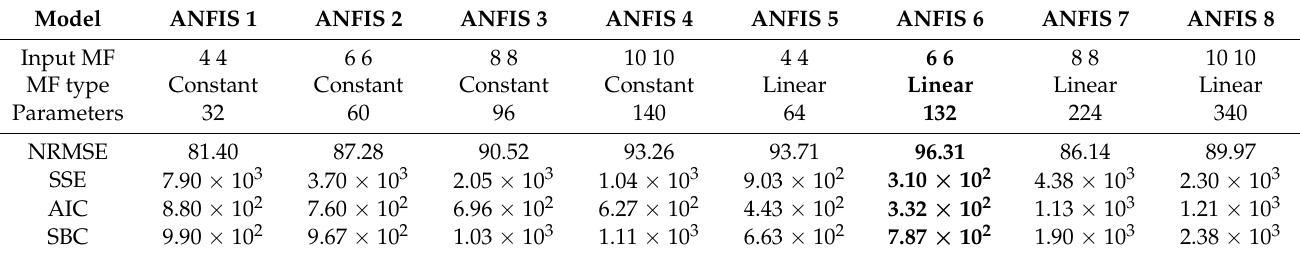
Table 15. Overview of the parameters of the created ANFIS models and performance metrics of the DMSP-5 muscle validation